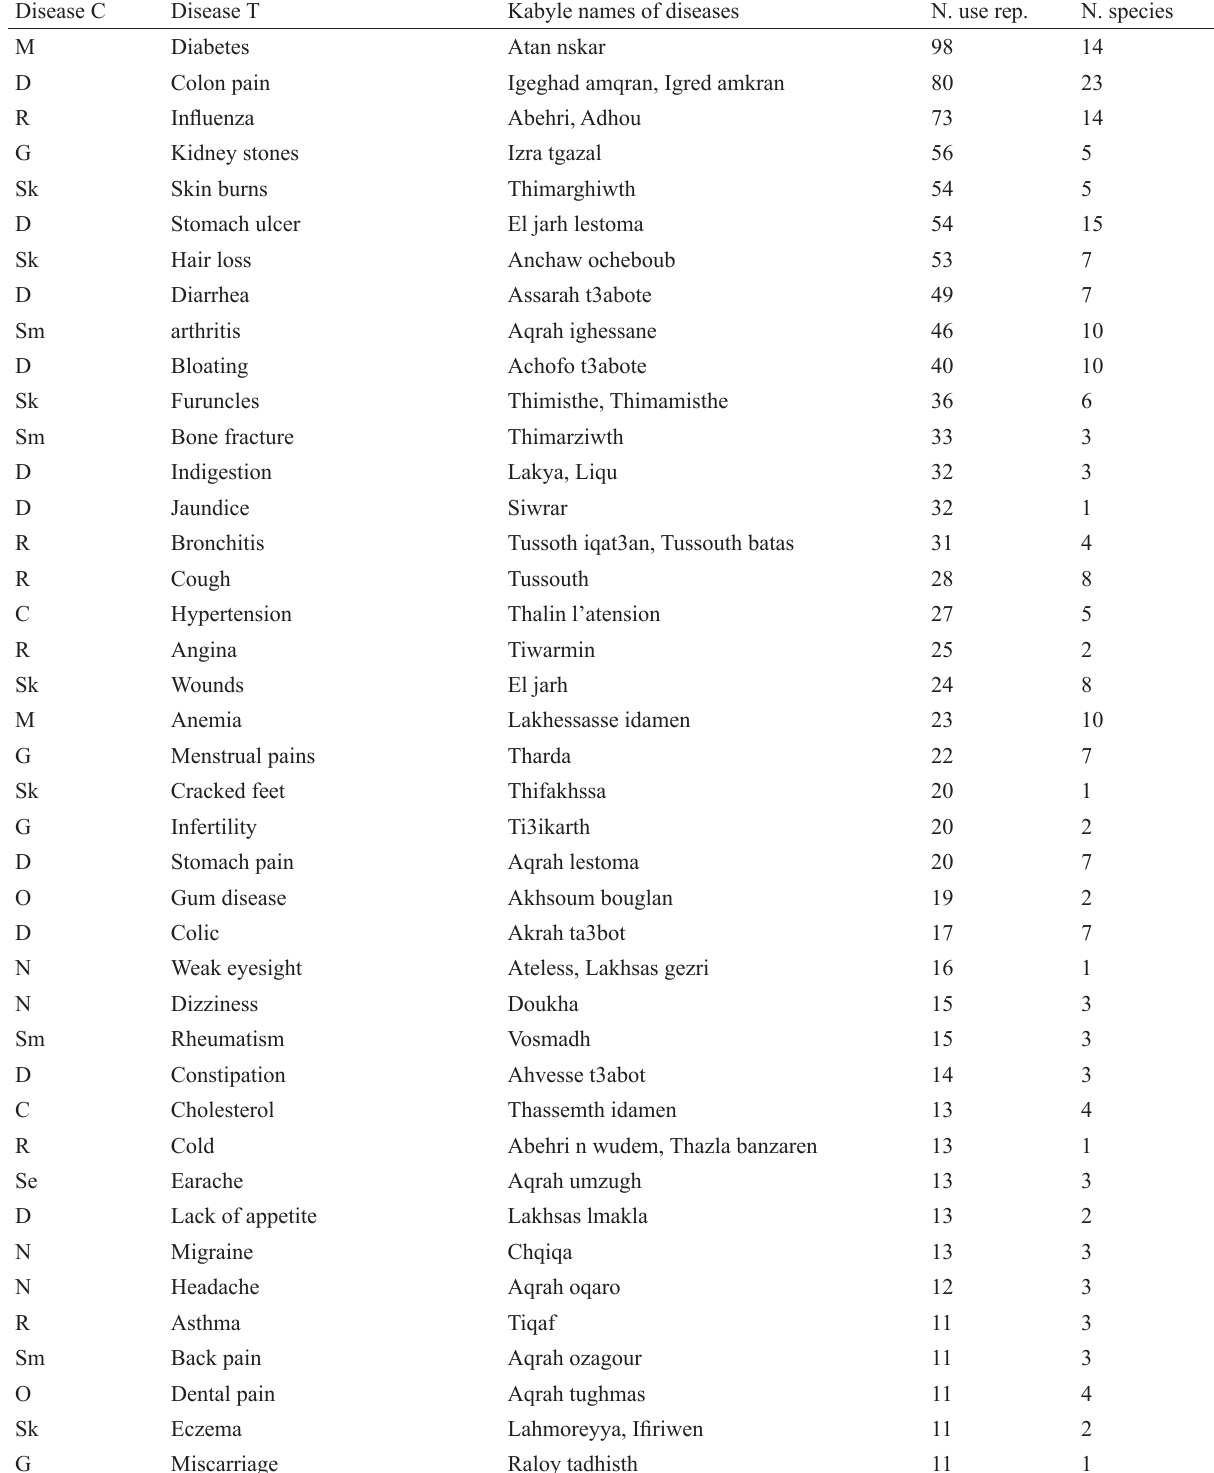
Table 3. Major disease categories (Disease C), disease treated (Disease T), their numbers of use reports (N. use rep.) and the number of plant species (N. species) in the study area. Disease C: D: digestive, R: respiratory, M: metabolic and nutritional, C: cardiovascular and circulatory, Sk: skin, Sm: skeletomuscular, G: genitourinary and reproductive, N: mental-nervous, O: oral-dental, Se: sensory. Disease C Kabyle names of diseases N. use